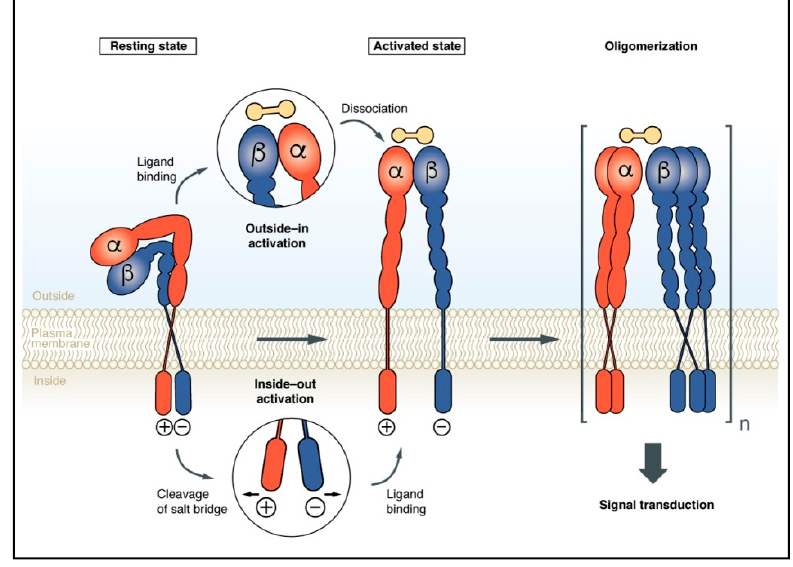
Figure 1. Schematic illustration of integrin activation and the “inside-out” and “outside-in” signaling mechanism. Integrins in the bent resting conformation reveal low affinity binding to their ECM ligands. The inside-out signaling involves disruption of the intracellular salt bridge, which is established between the cytoplasmic subunits. This induces dissociation of the transmembrane helices, followed by the reorganization and generation of a high affinity binding integrin, plus multimerization in focal adhesions. Conformational changes of the resting integrin state are induced by the integrin binding of ECM ligands causing stronger binding at the focal adhesions. The outside-in signaling requires integrin oligomerization [35].